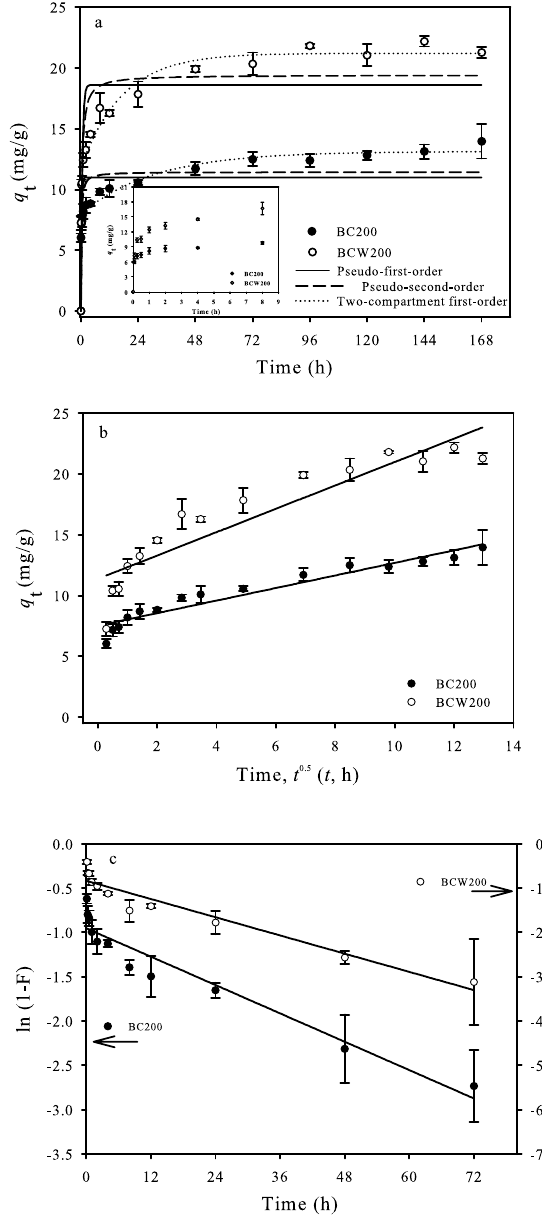
Figure 2. Sorption kinetics of OFL on U. P- biocharsby fitting the pseudo-first-order model, pseudo-second- order model and two-compartment first-order model ( a ) intraparticle diffusion model ( b ) and liquid-film